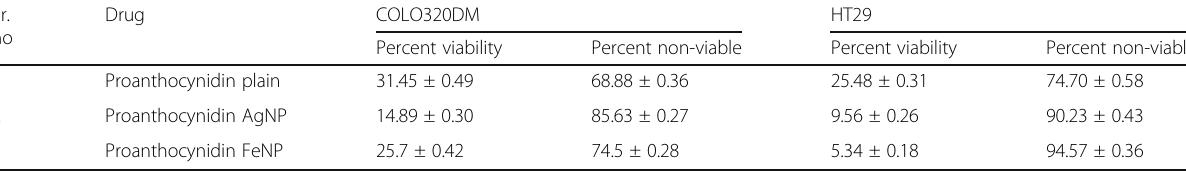
Table 3 Results of cytotoxicity of PAC, PACAgNPs, and PACFeNP by using Trypan blue assay Sr.